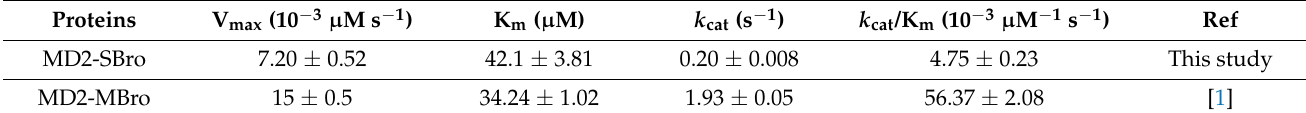
Table 3. Kinetic parameters of MD2-SBro in comparison to MD2-MBro.